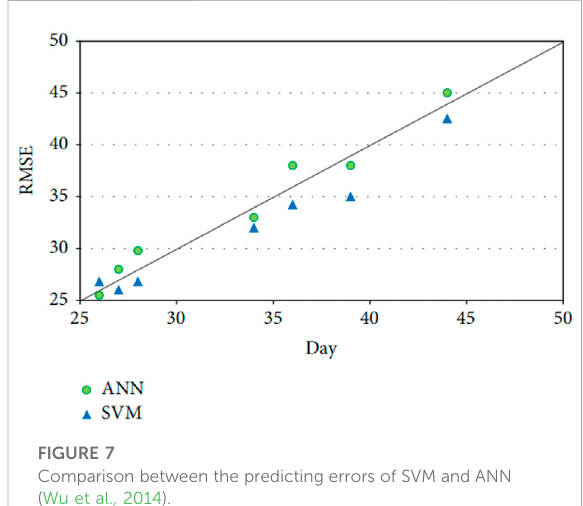
FIGURE 7 Comparison between the predicting errors of SVM and ANN (Wu et al.,